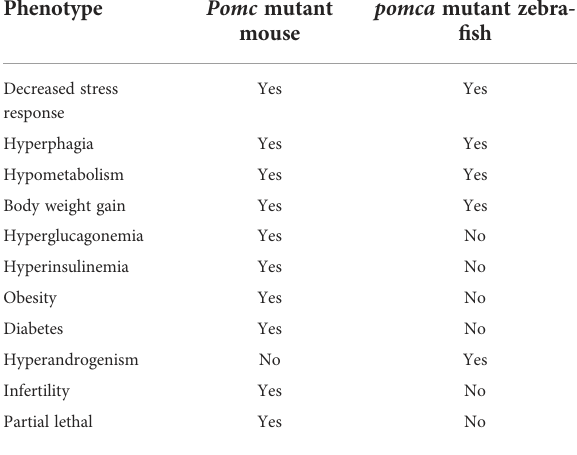
TABLE 4 Comparison of POMC action in mouse and zebra fi sh